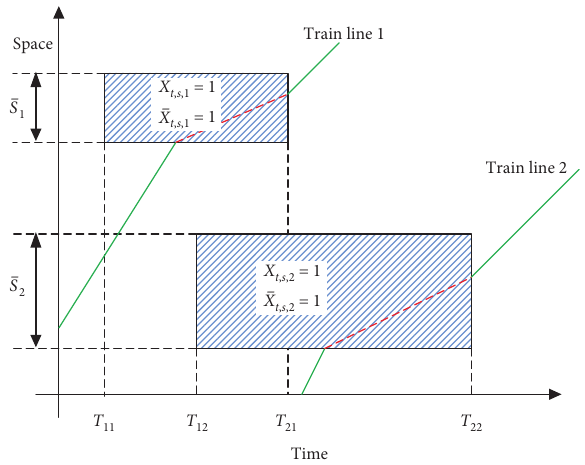
Figure 6: Identification method for multidisturbances related to speed